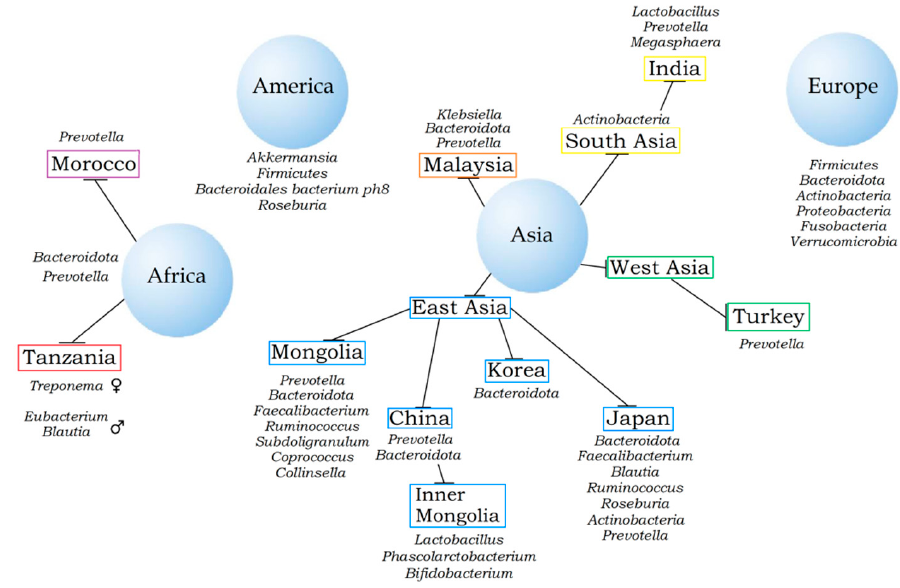
Figure 1. Features of the gut microbiota of different regional populations.